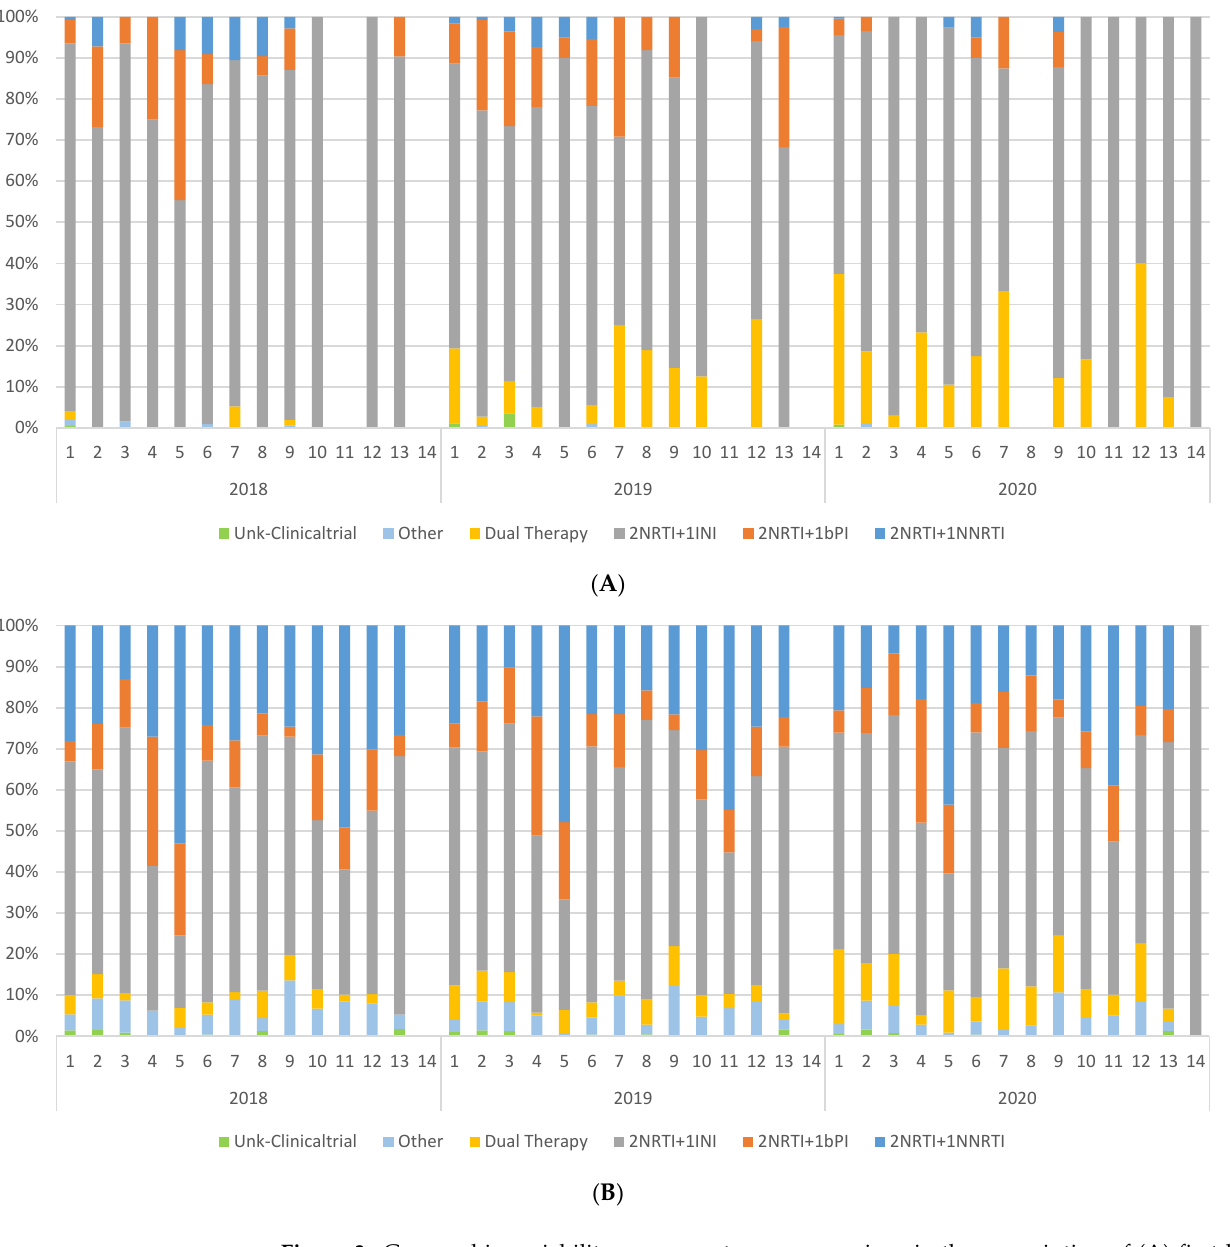
Figure 3. Geographic variability among autonomous regions in the prescription of ( A ) first-line antiretroviral regimen among treatment-naïve patients and (Dual therapies prescribed as initial treatment were DTG/3TC and ETR + RAL. Patients were not enrolled in the cohort in AR 11 in 2018 and 2019, or in AR 8 in 2020. AR 14 was included in the cohort in 2020). ( B ) ART regimen among all patients on treatment, by type of regimen, 2018–2020. (Dual therapies prescribed among patients on treatment were DTG/RPV, DTG/3TC, DRV/r + 3TC, DRV/r + RPV, DRV/r + ETV, DRV/r + DTG, DRV/r + RAL, CAB + RPV, ATV/r + 3TC, ETR + RAL, and DRVc + 3TC. AR 14 was included in the cohort in 2020). Each autonomous region (AR) is represented with a